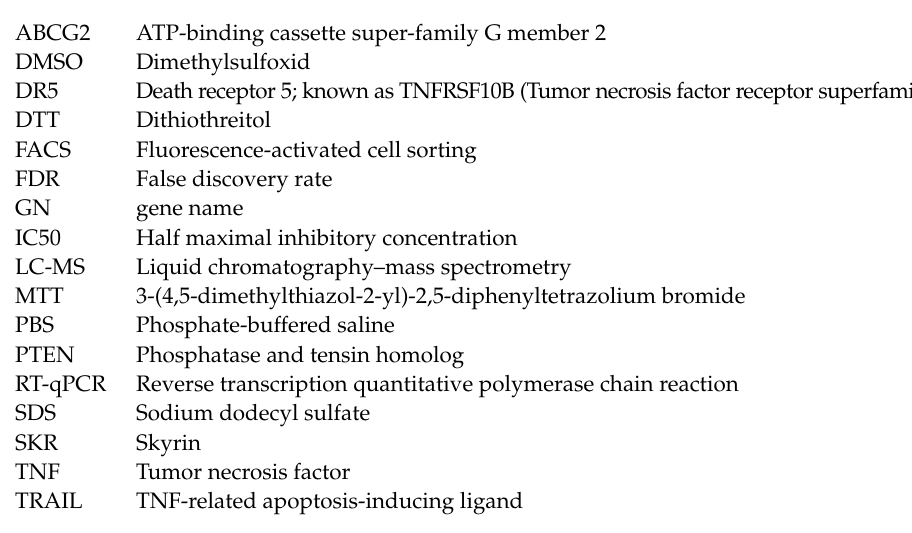
Figure S45: Melt curve after of the TNFRSF6B (DcR3) gene fragment amplified in RT-qPCR by oligonu- cleotide primers DcR3_for and DcR3_rev, Figure S46: Melt curve after of the PMM1 gene fragment, reference gene, amplified in RT-qPCR by oligonucleotide primers PMM1_for and